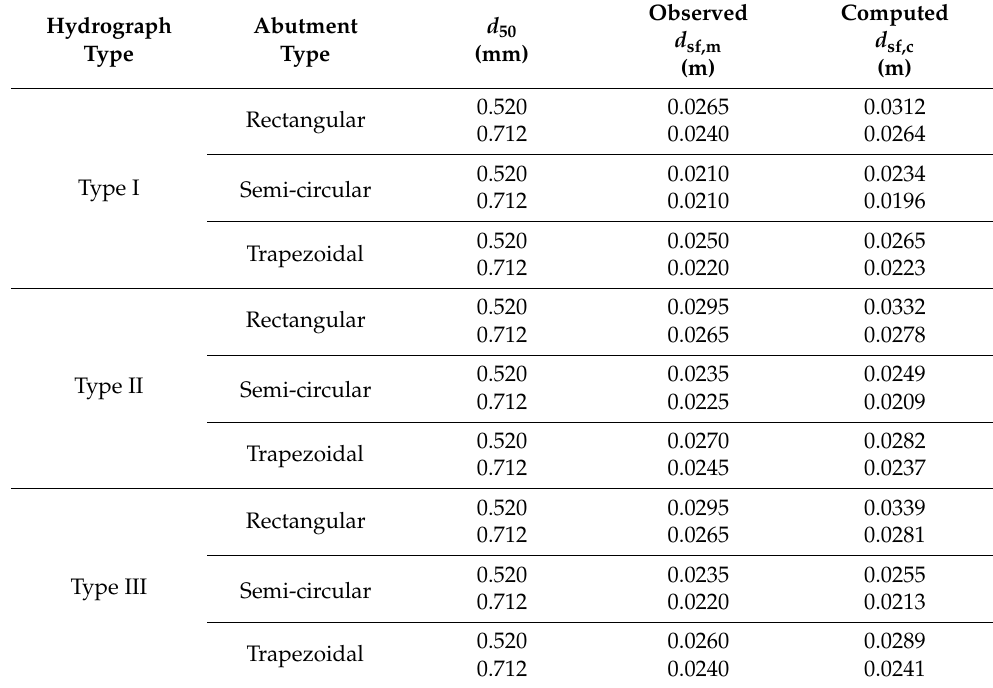
Figure 11. Comparison of computed and measured abutment-scour evolution under Type-III stepwise (delayed) hydrograph. ( a ) Rectangular abutment ( b ) Semicircular abutment ( c ) Trapezoidal abutment. Table 4. Comparison of observed and computed (Equation (1)) scour depth at abutment under unsteady